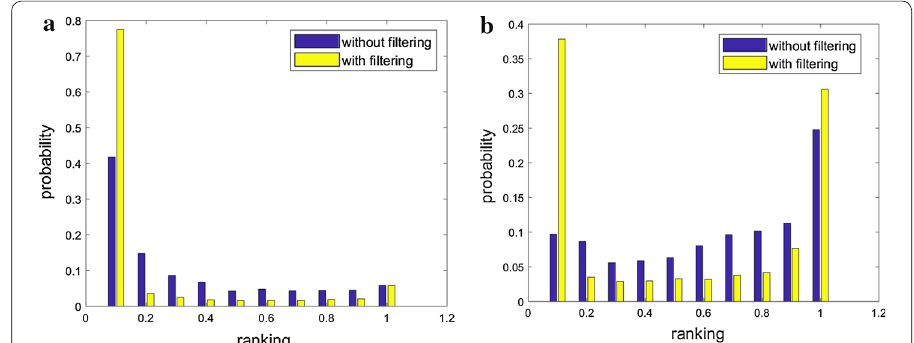
Fig. 3 Actual ranking distribution for testing labels with label 0 and 1 respectively (Naïve Bayes classifier, German dataset)